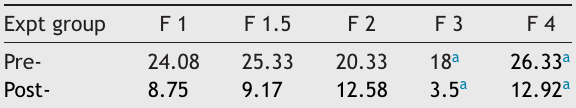
Values of DPOAE pre-conditioning with noise and post-exposure to an ototoxic dose of gentamicin --- Expt group.